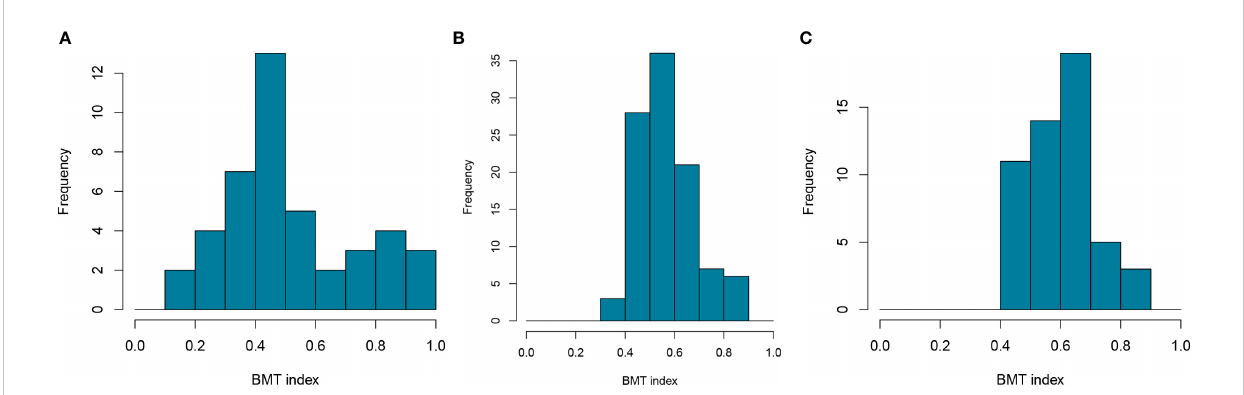
FIGURE 5 (A – C) . Frequency distribution of BMT Indices for (A) non-tuna UoAs; (B) Atlantic Ocean tuna and large pelagic UoAs; (C) Indian Ocean tuna and large pelagic